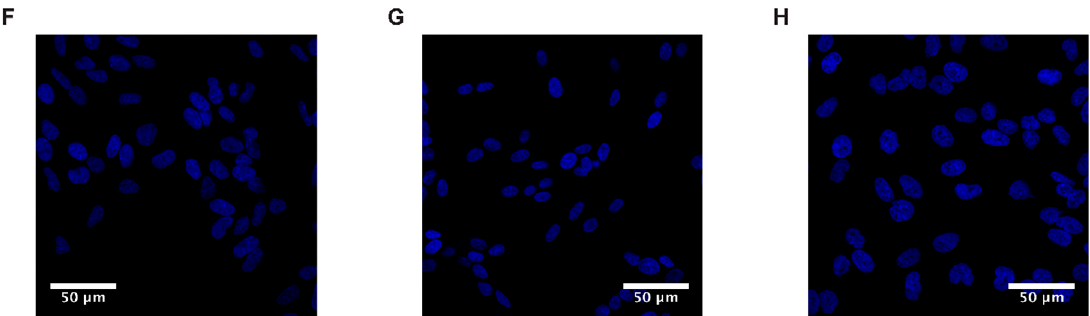
Figure 2. SYK mRNA and to a lesser extend SYK protein are expressed in neuroblastoma cell lines. ( A ) RT-PCR analysis demonstrating the expression of both SYK mRNA variants in different neuroblastoma cell lines. U937 cells were used as a positive control (PC). NTC, no template control. ( B ) Expression of SYK protein was determined by western blot. THP-1 cells were used as a positive control. Immunofluorescence labeling of SYK (green) in SH-SY5Y ( C ), LAN-6 ( D ) and SK-N-BE(2) cells ( E ). The nuclei (blue) were stained with Hoechst 33342. Panels ( F–H) display isotype controls for SH-SY5Y ( F ), LAN-6 ( G ) and SK-N-BE(2) cells ( H ).